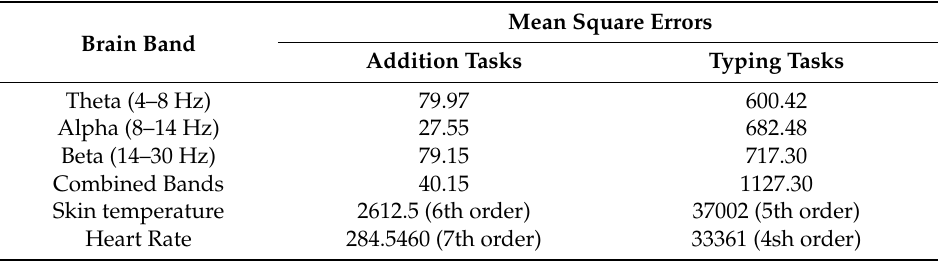
Table 6. MSE obtained from LASSO model using brain PSDs & from polynomial curve fitting models using physiological